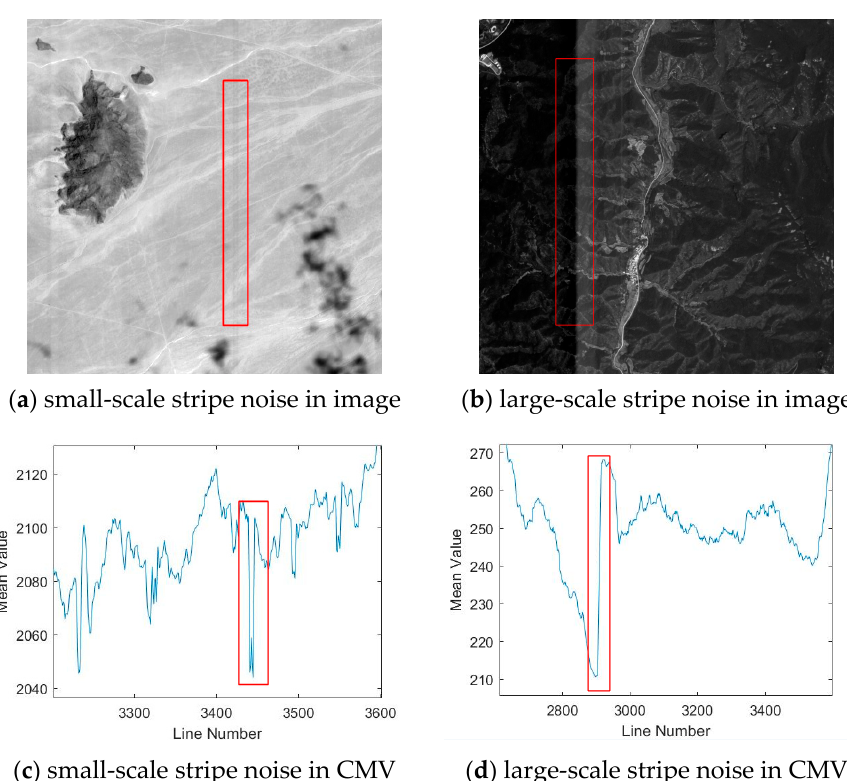
Figure 1. Stripe noise with different scales in image and corresponding column mean vector (CMV). Where ( a ) is small-scale stripe, ( b ) is large-scale stripe, ( c ) is the CMV of ( a ), ( d ) is the CMV of ( b ).